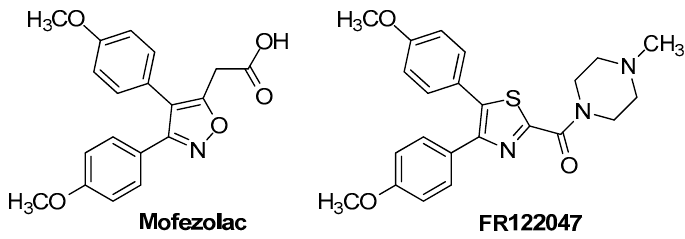
Figure 10. Chemical structures of COX inhibitors Mofezolac and FR122047 .